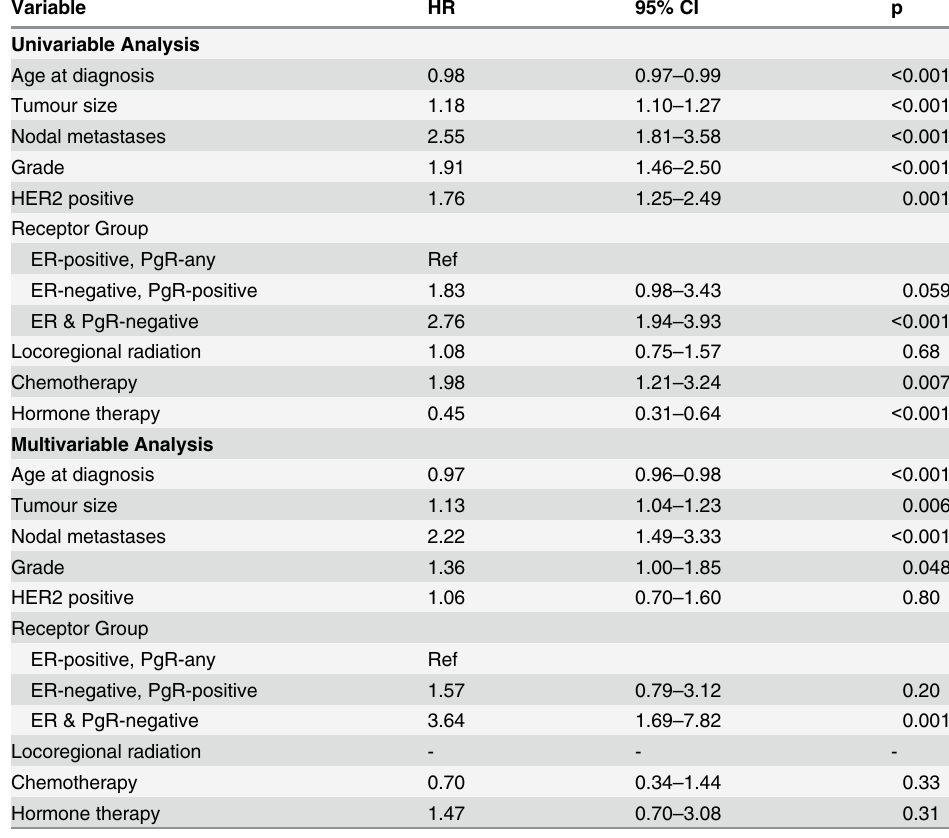
Table 2. Univariable and multivariable analyses for time to